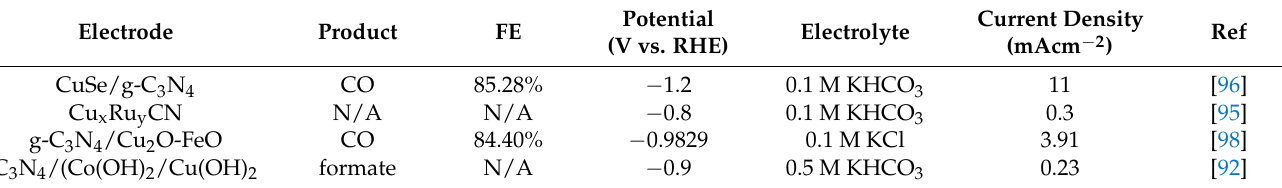
Table 5. The electrocatalytic parameters of bimetallic doped g-C 3 N 4 catalysts in eCO 2